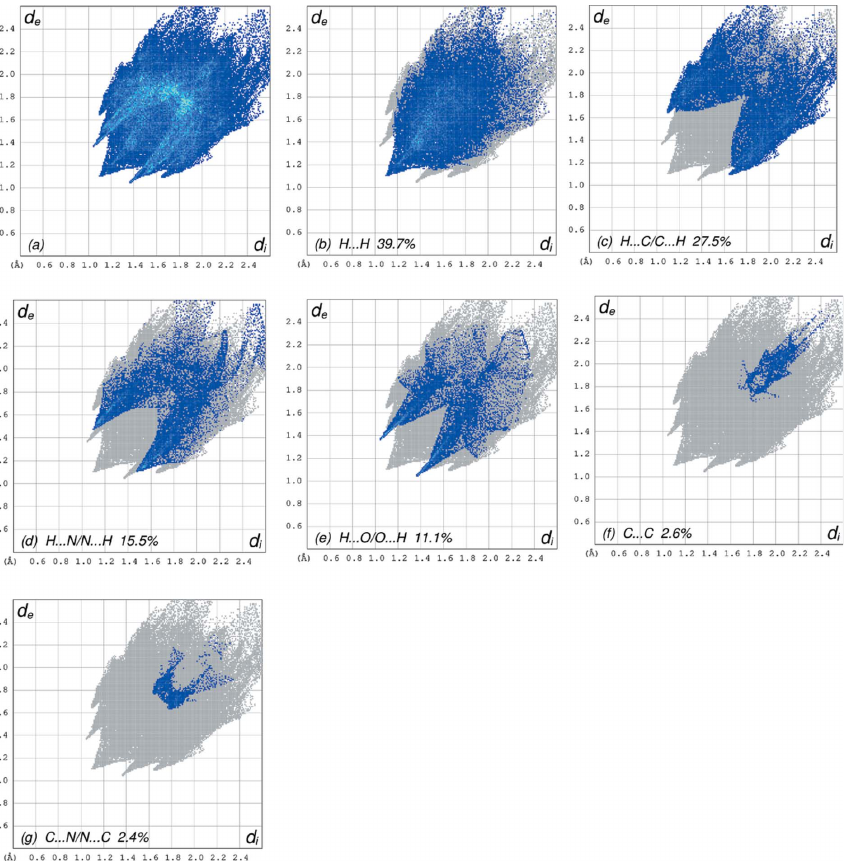
Figure 6 The full two-dimensional fingerprint plots for the title compound, showing ( a ) all interactions, and delineated into ( b ) H (cid:2)(cid:2)(cid:2) H, ( c ) H (cid:2)(cid:2)(cid:2) C/C (cid:2)(cid:2)(cid:2) H, ( d ) H (cid:2)(cid:2)(cid:2) N/N (cid:2)(cid:2)(cid:2) H, ( e ) H (cid:2)(cid:2)(cid:2) O/O (cid:2)(cid:2)(cid:2) H, ( f ) C (cid:2)(cid:2)(cid:2) C and ( g ) C (cid:2)(cid:2)(cid:2) N/N (cid:2)(cid:2)(cid:2) C interactions. The d i and d e values are the closest internal and external distances (in A˚ ) from given points on the Hirshfeld surface contacts.